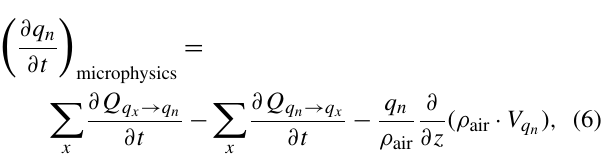
Figure 1. Sketch representing the fundamentals of the moisture tracers method, including the tagging of 3-D and 2-D moisture sources.